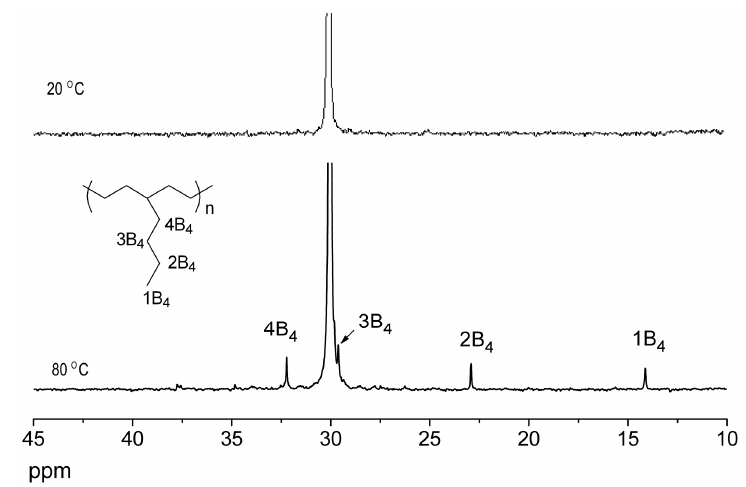
Figure 1. 13 C NMR spectra of PE obtained by 1 /MAO at different temperatures.